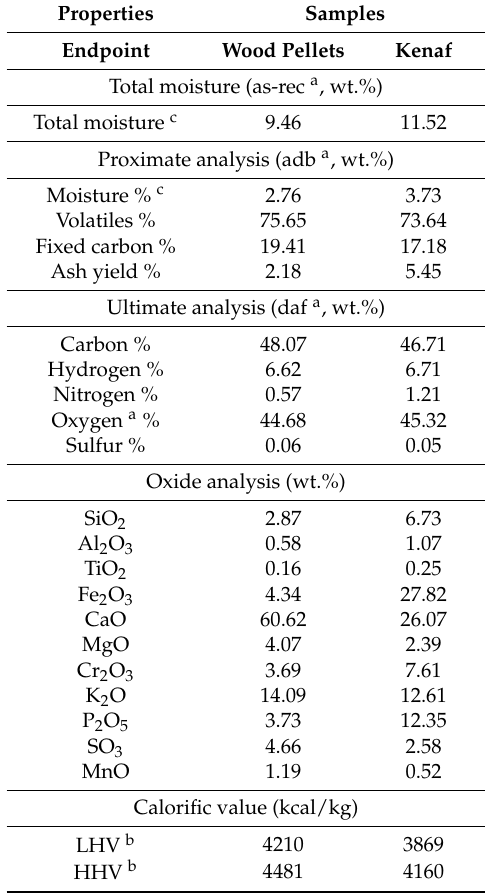
Table 1. Proximate, ultimate, and oxide analysis results and calorific values of biomass samples.